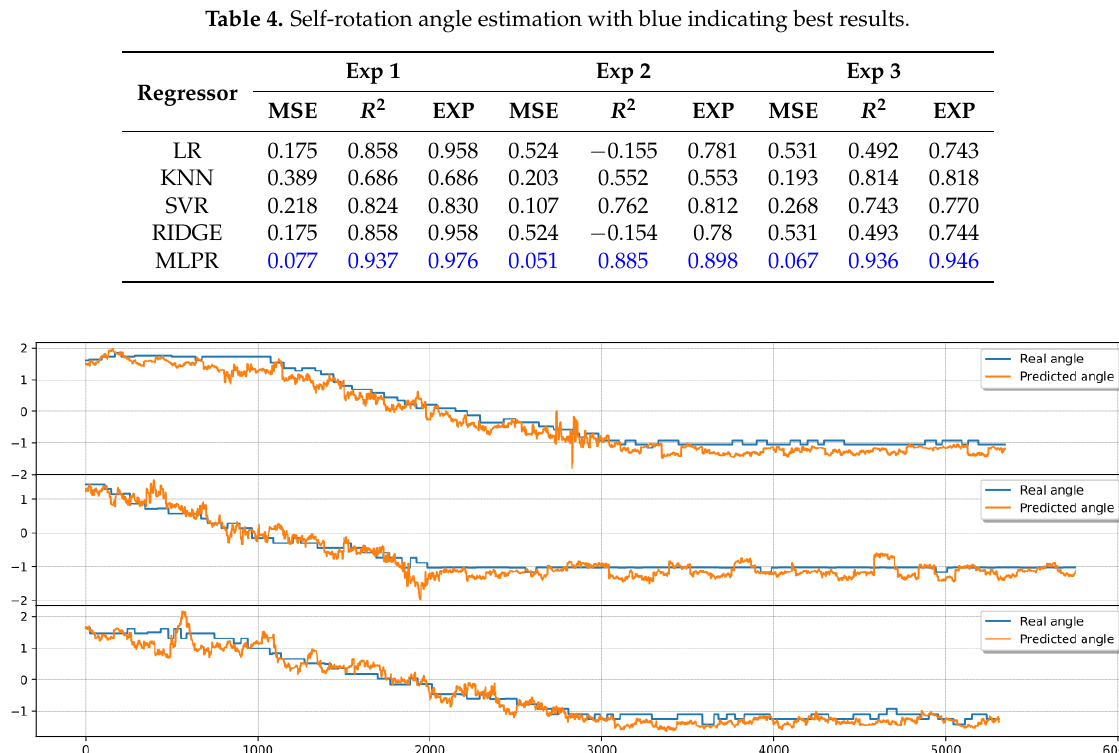
Figure 18. Prediction of angle compared to real angle using Multilayer perceptron (MLP) during self object